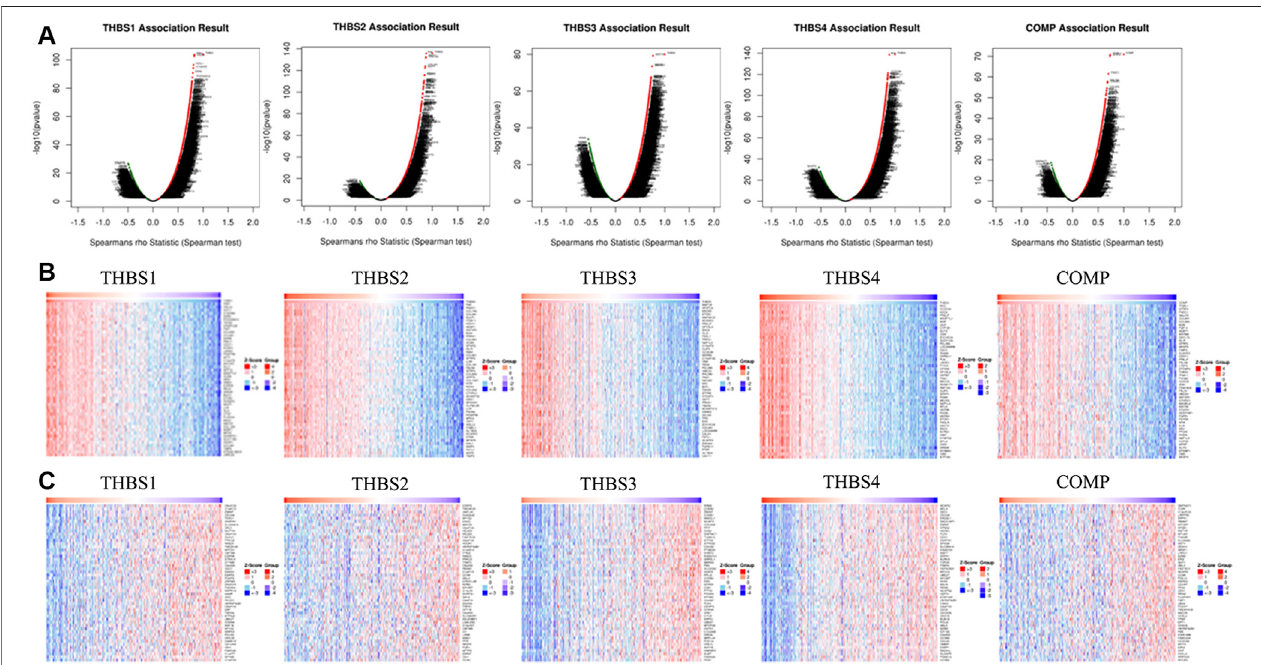
FIGURE 4 | (A) Volcano plots showing the correlations between THBSs and genes differentially expressed in gastric cancer (GC); (B) heat maps showing top 50 genes positively correlated with THBSs in GC; (C) heat maps showing top 50 genes negatively correlated with THBSs in GC. Red indicates positively correlated genes and blue/green indicates negatively correlated genes (LinkedOmics).